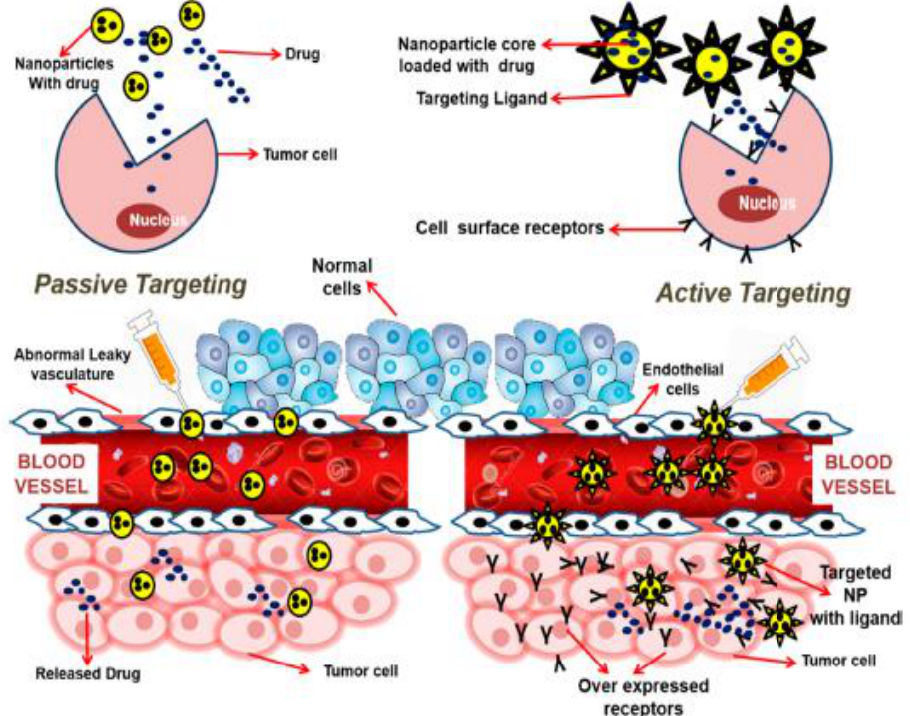
Figure 2. Active and passive targeting approaches in cancer nanotherapeutics. Reproduced from Ref. [32], (2022), with permission from American Chemical Society (ACS).